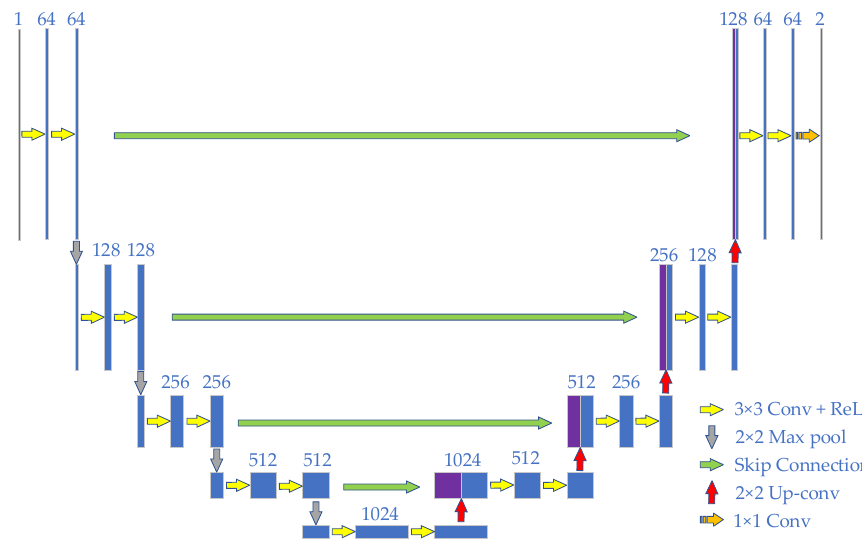
Figure 4. U-Net network structure diagram.